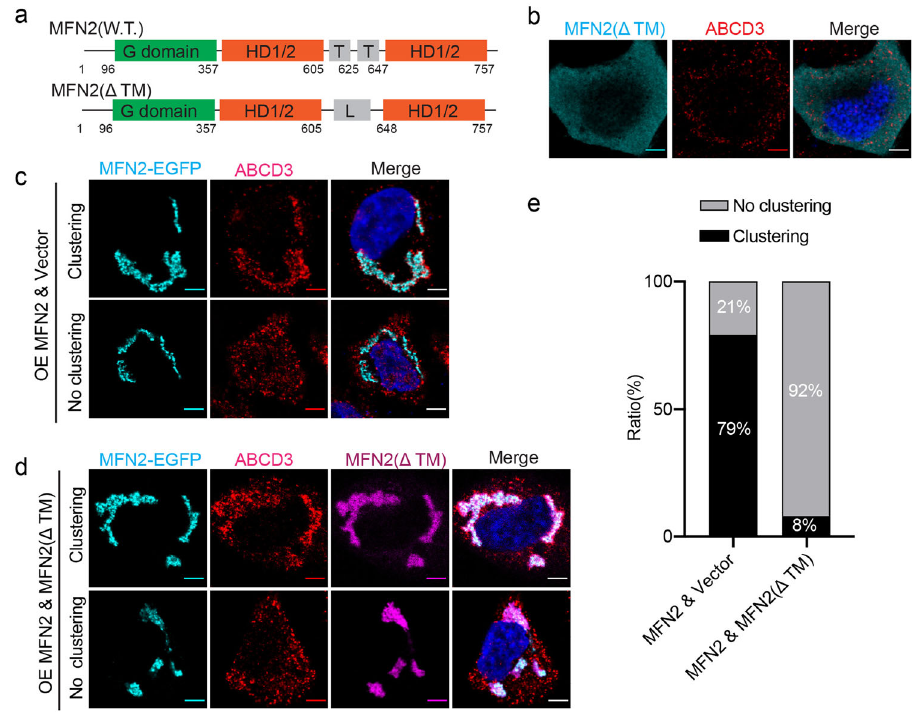
Fig. 6 MFN2( Δ TM) blocks mitochondrion-peroxisome clustering. a Schematic of the organization of wild type MFN2 and MFN2( Δ TM). G domain, GTPase domain; HD1/2, helical domain 1/2; T, transmembrane region; L, a Gly-Ser linker. Amino acids 606 – 647 in wild-type MFN2 were replaced with a 10 amino acid linker GGSGGGSGGG. b Confocal micrographs of HeLa cells transfected with FLAG-tagged MFN2( Δ TM). Cells were immunostained for endogenous ABCD3 (Alexa Fluor 647) and FLAG (Alexa Fluor 555). Representative confocal micrographs of HeLa cells transfected with ( d ) or without ( c ) MFN2( Δ TM)-FLAG. MFN2-EGFP was overexpressed to induce mitochondrion-peroxisome clustering in both conditions. Cells were stained for ABCD3 and MFN2( Δ TM)-FLAG. e The statistics of cell numbers in different stages were analyzed for experiments in c ( n = 240 cells) and d ( n = 106